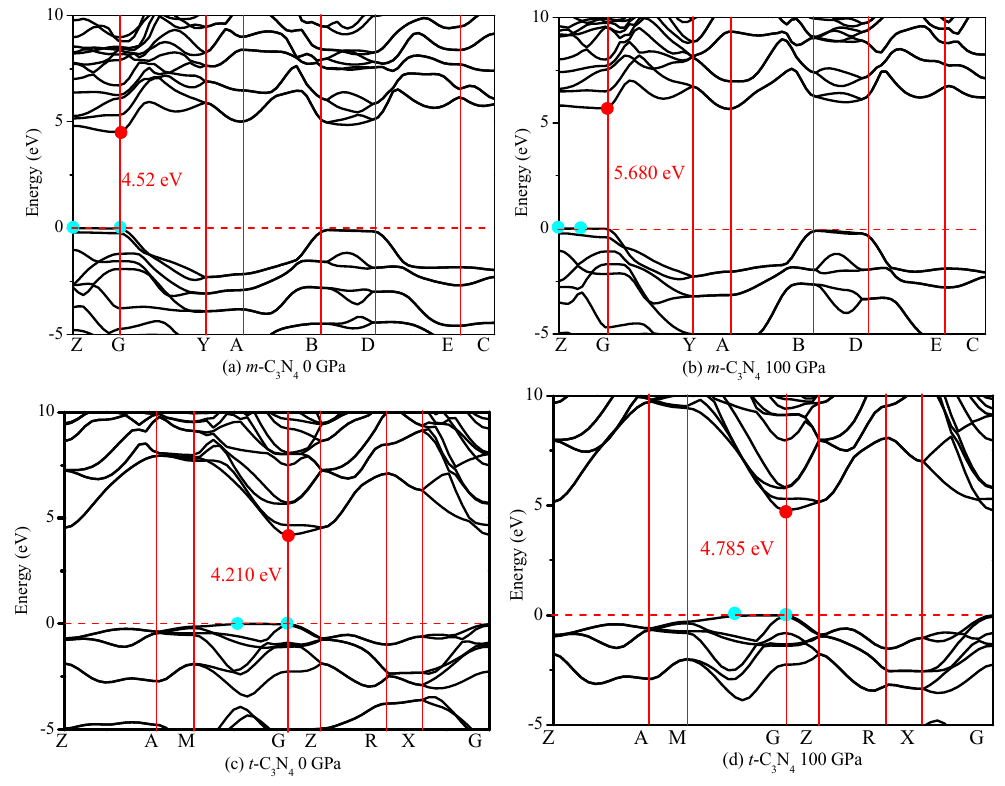
Figure 10. Electronic band structure of: m -C 3 N 4 ( a , b ); and t -C 3 N 4 ( c , d ) with HSE06.